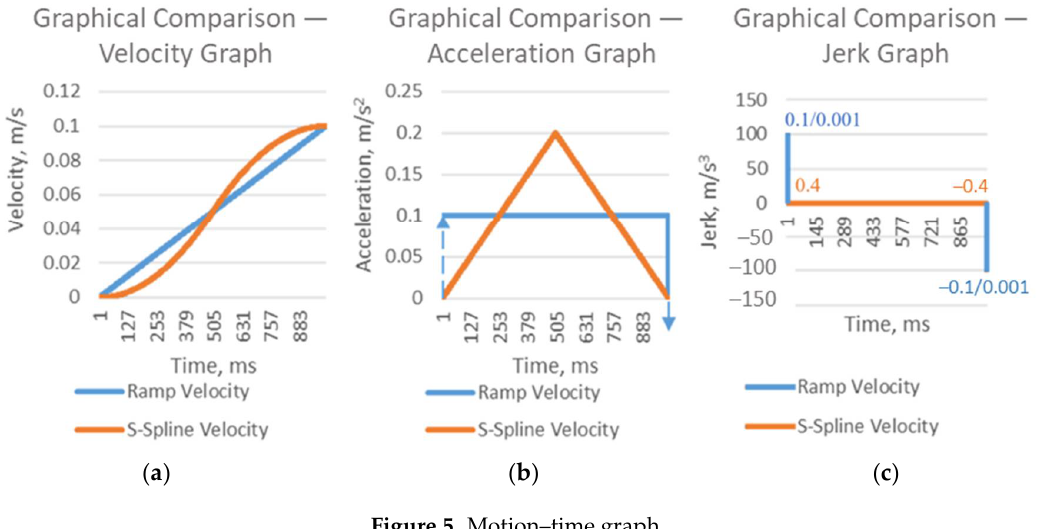
Figure 5. Motion–time graph.